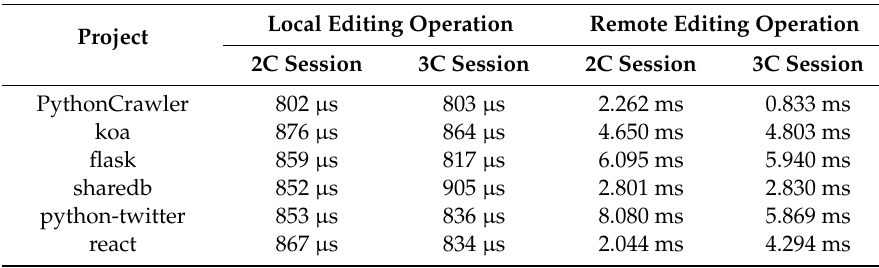
Table 3. Average processing times of local and remote editing operations in two-collaborator sessions (2C sessions) and three-collaborator sessions (3C